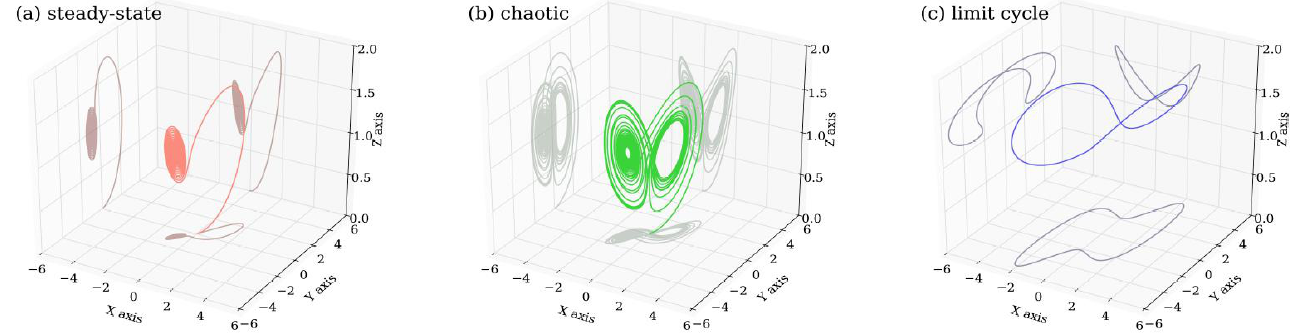
Figure 3. Three types of solutions within the X – Y – Z phase space obtained from the Lorenz 1963 model. Panels ( a – c ) display a steady-state solution, a chaotic solution, and a limit cycle with small, medium, and large heating parameters, respectively. While panels ( a , b ) show the solution for τ ∈ [0,30] panel, to reveal its isolated feature, panel ( c ) displays the limit cycle solution for τ ∈ [10,30]. Values of parameters are the same as those in the control run in Figure 2.